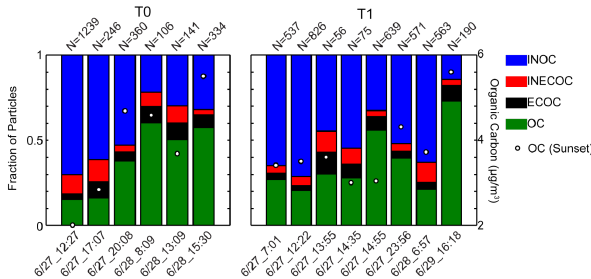
Fig. 7. Fractions of STXM-derived particle types for different sites (T0 and T1), dates, and times. White dots show organic carbon mass Figure 7. Fractions of particle types for different sites (T0 and T1), dates, and times. White 3 concentration determined by the Sunset OCEC dots show organic carbon mass concentration determined by the Sunset OCEC analyzer. The 4 numbers of analyzed particles (N) are shown above the bars for each sample. 5